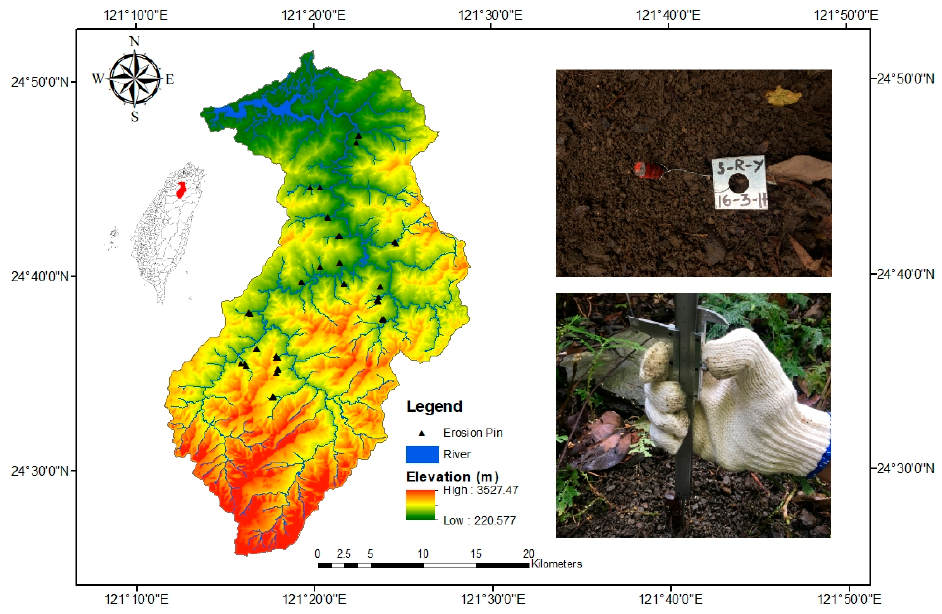
Figure 2. The study area and locations of erosion